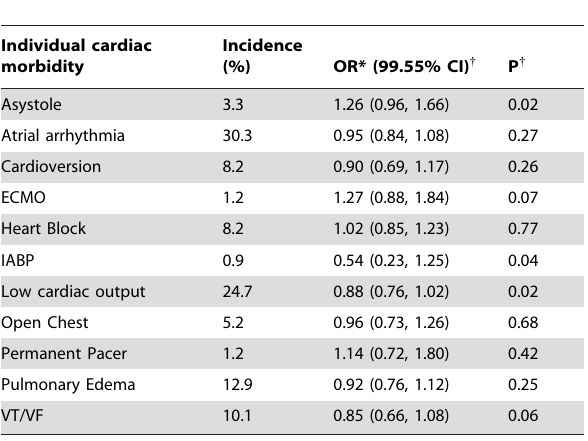
Table 2. The associations between serum vitamin D concentration and individual cardiac morbidities among 426 cardiac surgical patients.